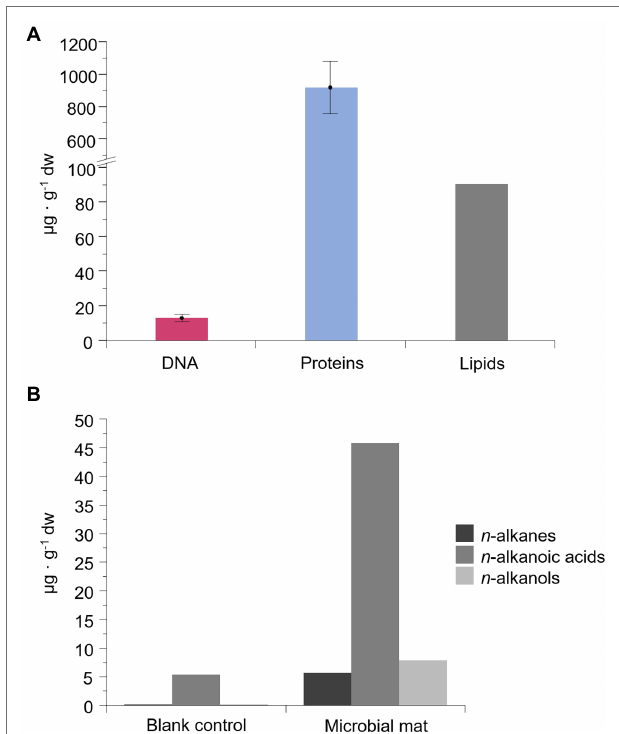
FIGURE 4 | Concentration of DNA, proteins, and lipid compounds in the microbial mat ( μ g·g − 1 of dry weight). In (A) , concentration of intracellular and surface-bound extracellular DNA and proteins, and total lipids. “Surface- bound” refers to the fraction of extracellular DNA and proteins attached to organic or inorganic compounds. Error bars are the SD of triplicates. In (B) , concentration of the three most abundant lipidic families: straight-chain or normal ( n- ) alkanes, alkanoic acids, and alkanols. Results from an organic- solvent extraction without a sample (blank control) is also represented for the lipid